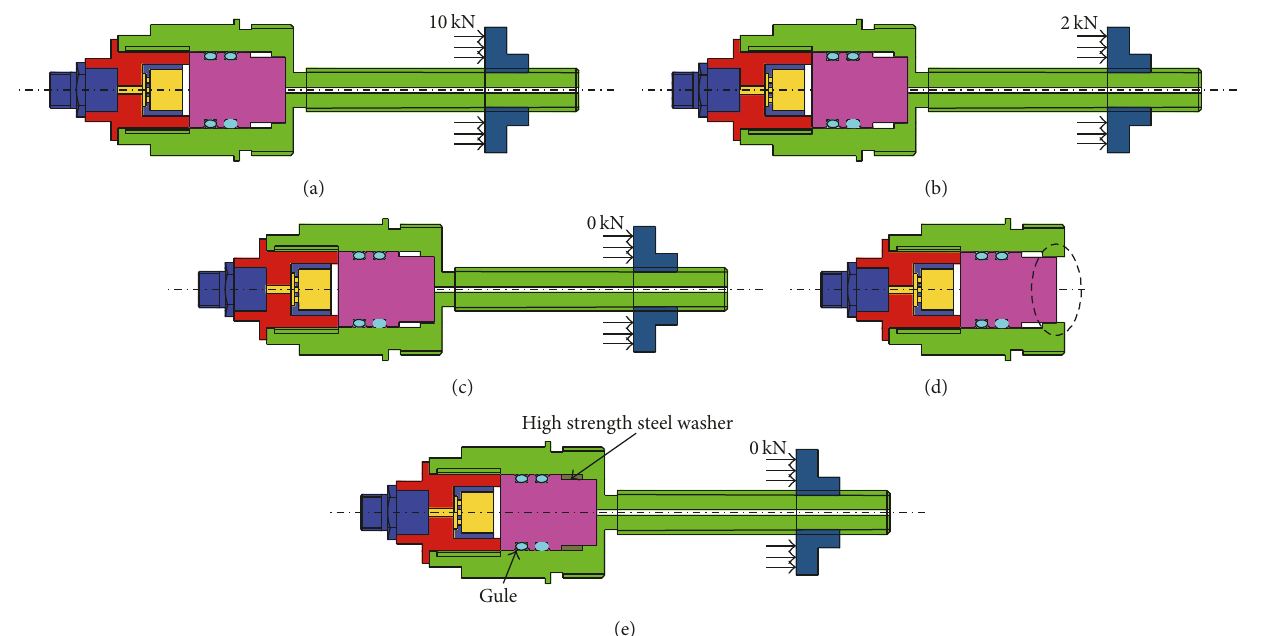
Figure 8: Five different states of explosive bolts: (a) state 1; (b) state 2; (c) state 3; (d) state 4; and (e) state 5.